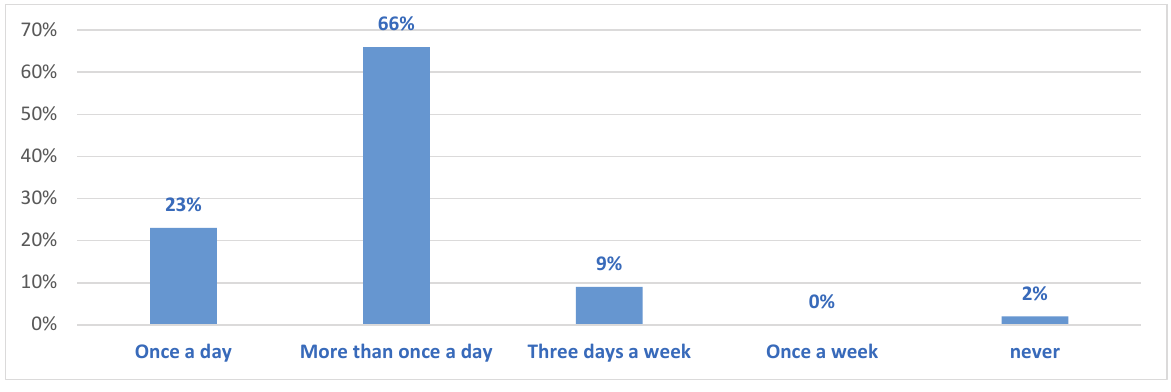
Fig. 3. The frequency usage of the OSMNs